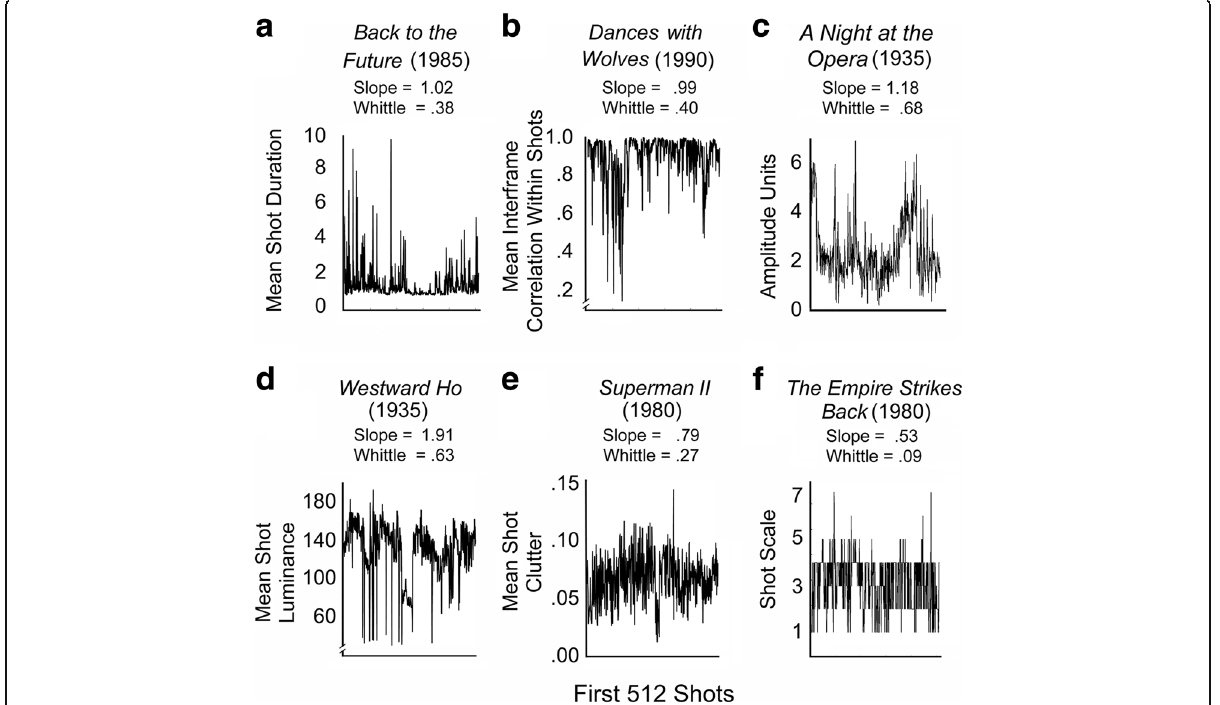
Fig. 2 Waveforms for six dimensions of movies – a shot duration, b motion, c sound amplitude, d luminance, e clutter, and f shot scale – taken from the first 512 shots in six movies. The first and waveforms like it are the focus of Studies 1, 2, and 4; the latter five and waveforms like them from other movies are discussed in Studies 5 and 6. Slope=the value of alpha in 1/ f α ; Whittle=a fractional estimate of vector complexity. Both are discussed in the